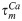
The time constants of ICa activation and inactivation control fres and Zmax.The Z(f) profiles are plotted for a randomly selected optimal model (green) at different values of τmCa (a) and τhCa (b). Note that fres of the control (100%) values are at 1 Hz (dashed vertical line). The currents ICa, IL and Itotal plotted as a function of cycle phase at 50% (c1, d1), 100% (c2, d2), and 150% (c3, d3) of the control values of τmCa (c) and τhCa (d). In each panel of c and d, the currents are shown at 1 Hz (along the dashed lines in a, b) and at fres (filled circles in a, b).